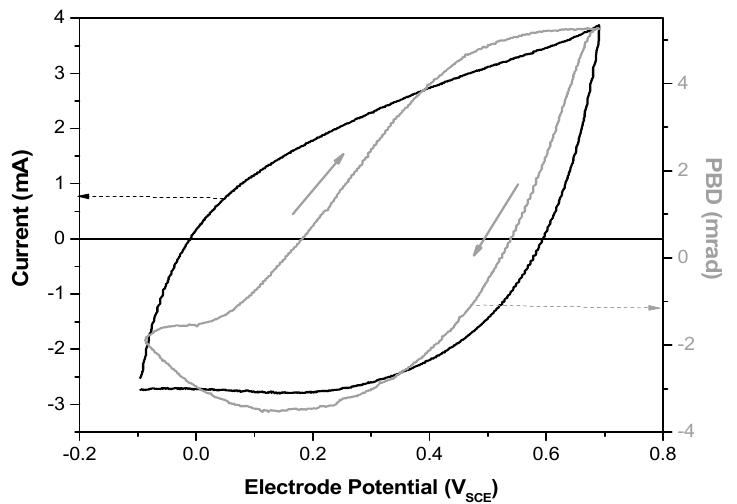
Figure 10. Cyclic voltammogram (CV, black line) and deflectogram (PBD, gray line) of a c(RF@F) electrode in 1 M KNO 3 . Scan rate = 1 mVs − 1 . Dashed arrows point to the axis of the measurement. Thick full arrows show the sense of PBD signal change.